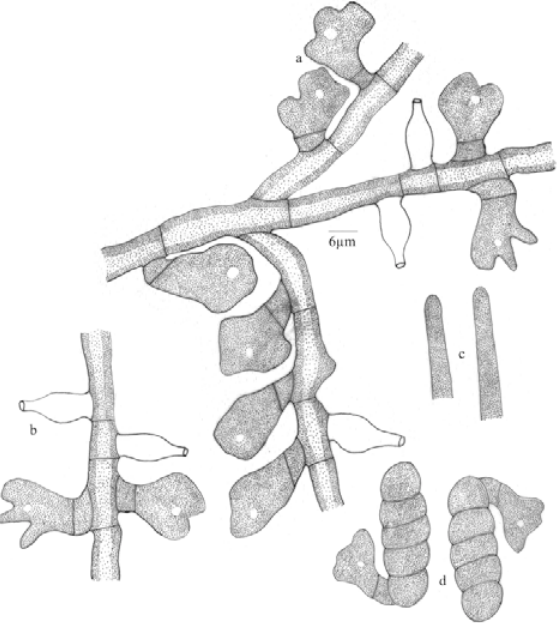
Figure 43. Meliola aporusae a - Appressorium; b - Phialide; c - Apical portion of mycelial setae;